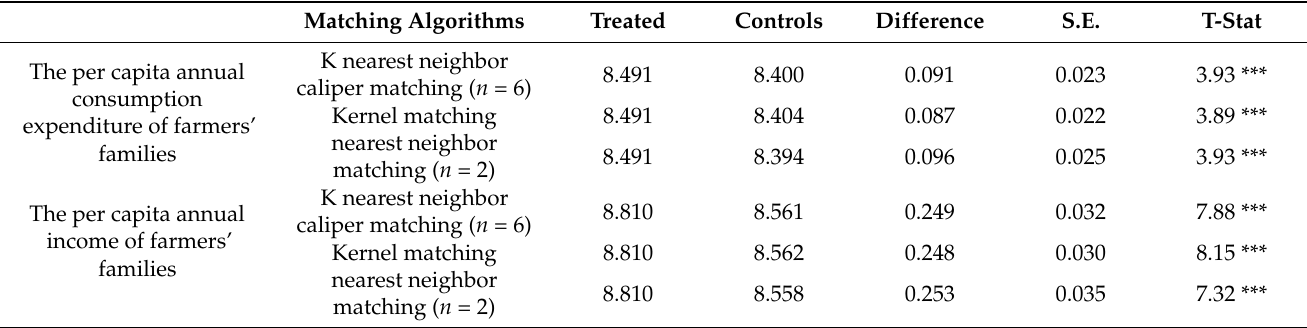
Table 7. The processing effect of propensity score